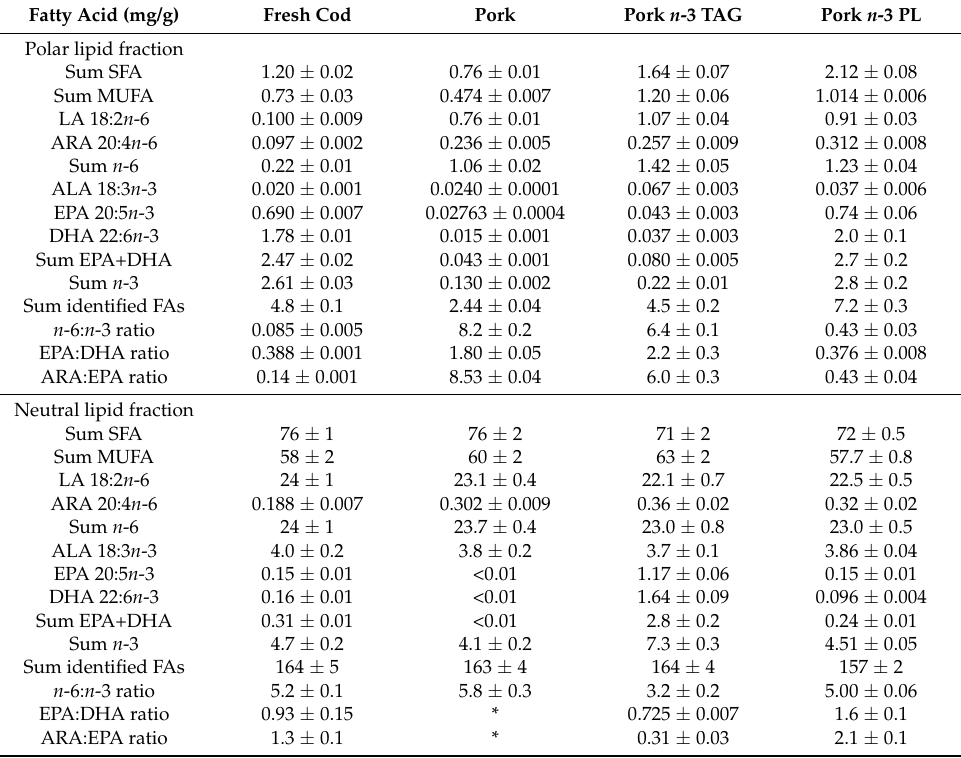
Table 2. Fatty acid composition in the polar and neutral lipid fractions isolated from Western diets. Fatty Acid